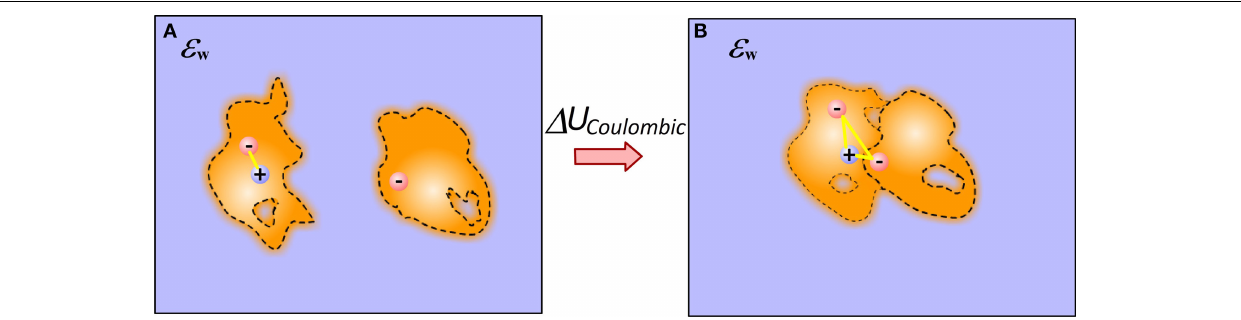
FIGURE 1 | Schematic presentation of electrostatic interactions between two molecules illustrating the origin of Coulombic component of binding energy in case of end-points approach. (A) Monomers; (B) Complex. The inhomogeneity of molecules is shown with